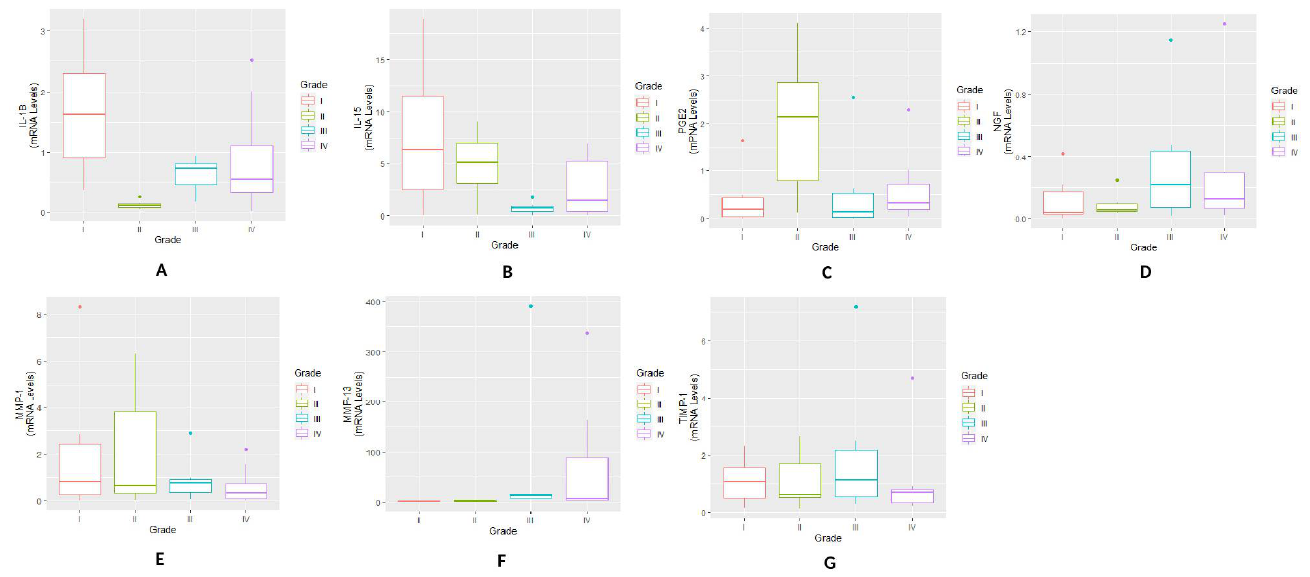
Figure 1. Synovial biopsy gene expression study—various pro-inflammatory markers and MMP expressions were estimated in synovial biopsy samples obtained from different grades of OA patients ( n = 26) ( A ) a grade-wise expression of IL-1 β ; the highest expression was found in the samples collected from OA patients with KL grade-I and the lowest expression was noted in KL grade-II samples. A significant difference was noted between KL grade-I and II ( p < 0.05). ( B ) expression trend of IL-15 showed a grade-wise decline. A trivial increase was noted in KL grade-IV samples; the highest expression was noted in KL grade-I biopsies. A significant difference was noted between KL grade-I and III ( p < 0.05). ( C ) a grade-wise expression trend of PGE2 with the highest expression in KL grade-II biopsies; inter-grade comparison did not reveal any significant difference among all the KL grades. ( D ) expression pattern of NGF, where the highest expression was seen in KL grade-IV synovial samples; no significant difference was noted among the grades during inter-grade comparison. ( E ) a grade-wise expression trend of MMP-1, where a grade-wise decline was found in the expression; the highest expression of MMP-1 was seen in KL grade-I biopsies. ( F ) expression pattern of MMP-13 showed a grade-wise increase; the highest expression was noted in the KL grade-III. ( G )TIMP-1 revealed a comparable expression trend in all the KL grades. MMP-1, MMP-13 and TIMP-1 did not reveal any statistically significant difference for inter-grade